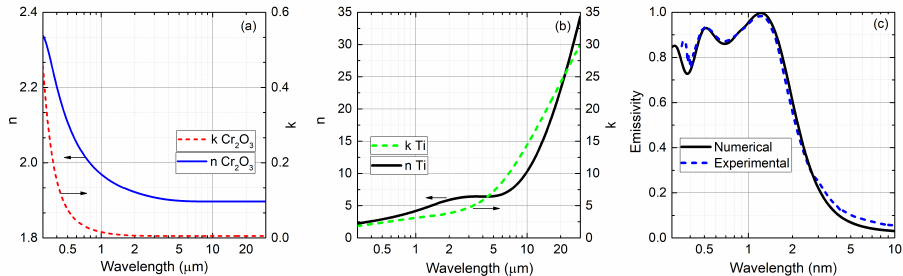
Figure 3. ( a , b ) Complex refractive index for Cr 2 O 3 and Ti respectively: real part n on the left axis, imaginary part k on the right axis. ( c ) Emissivity curve of Cr 2 O 3 /Ti/Cr 2 O 3 multilayer: experimentally measured absorptance (blue dotted line) and numerical simulation (black